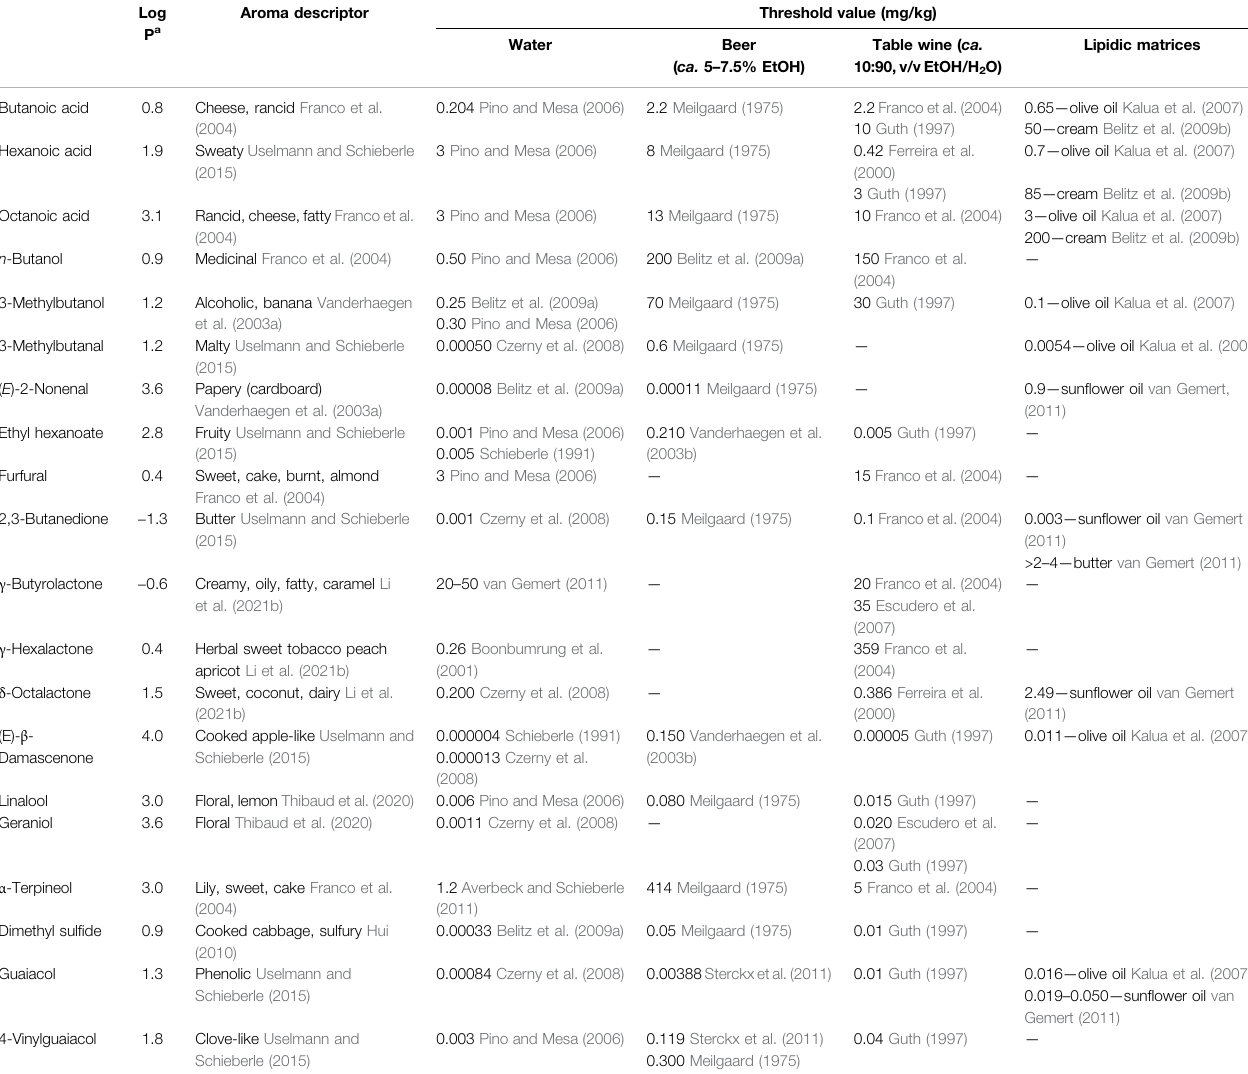
TABLE 1 | Aroma descriptors and odor threshold values of a set of volatile compounds belonging to different chemical families, determined in water, beer, table wine, and lipidic matrices Log P a